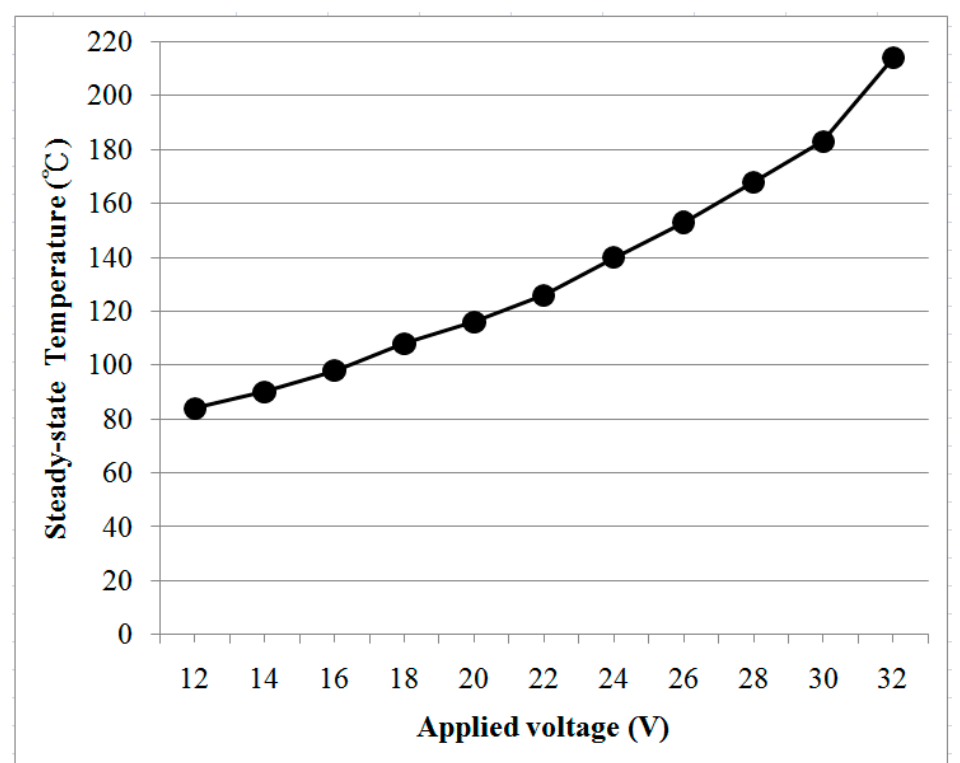
Figure 6. Steady-state temperature versus applied voltage of the graphene-based heater with three heating zones.